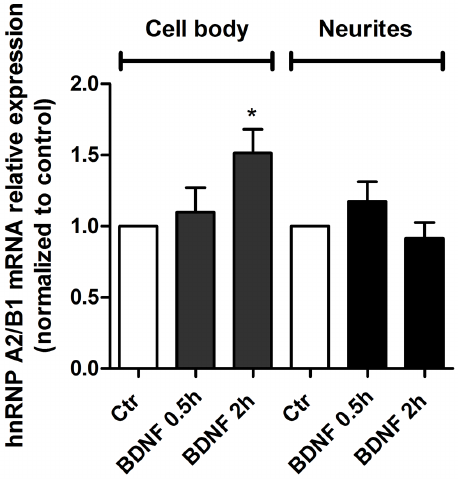
Figure 5. BDNF upregulates hnRNP A2/B1 mRNA in the cell body compartment of hippocampal neurons. Cultured hippo- campal neurons were stimulated or not with 100 ng/ml BDNF, for 30 min or 2 h. The cell body mRNA was mechanically separated from the transcripts of neurites and 500–1000 ng of RNA from each compartment was used in the reverse transcription reaction. The analysis of hnRNP A2/B1 mRNA levels was performed by qRT-PCR using Ppia as internal control gene. The results are the average 6 SEM of five (cell body compartment) or seven (neurite compartment) independent transcription reactions, performed in distinct preparations. Statistical analysis of logtransformed expression data was performed by one-way ANOVA, followed by Dunnet’s test. * P ,